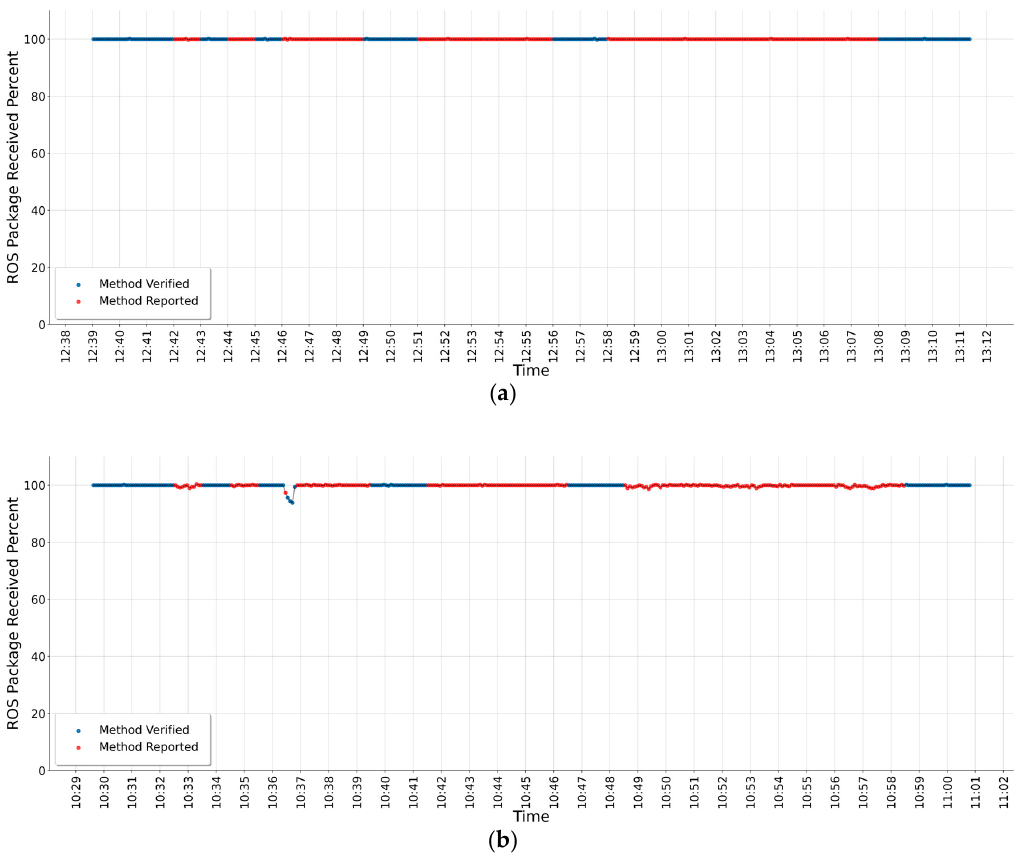
Figure 6. Test results of runtime verification method for different attack types: ( a ) DoS attack; ( b ) SYN Flood attack.